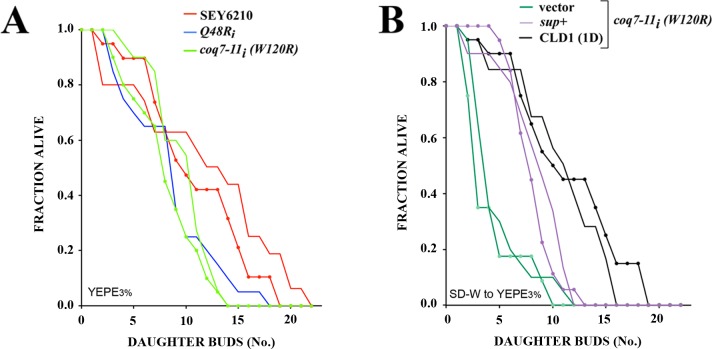
CLD1 overexpression lengthens the replicative lifespan of coq7 hypomorphs.(A, B) Replicative lifespan analyses of the indicated yeast strains cultured at 25°C on YEPE3%. Duplicate lifespan experiments for each line are provided (n = 20 virgin mother cells per strain per experiment). The following strain comparisons were significantly different (p<0.05) after pooling data across replicate experiments [mean replicative lifespan, p-value (log rank test)]. In panel (A), Q48Ri vs. SEY6210 (6.1 vs. 9.2, p<0.0009), coq7-11i(W120R) vs. SEY6210 (6.8 vs. 9.2, p<0.0008). In panel (B), vector (pRS424) vs. sup+ (2.4 vs. 6.3, p~0), vector vs. CLD1 (1D) (2.4 vs. 9.1, p~0), and CLD1 (1D) vs. sup+ (p < .002). coq7-11i(W120R) derivatives were cultured on synthetic selective media prior to transferal to YEPE3%. All other strains were maintained continuously on YEPE3%.